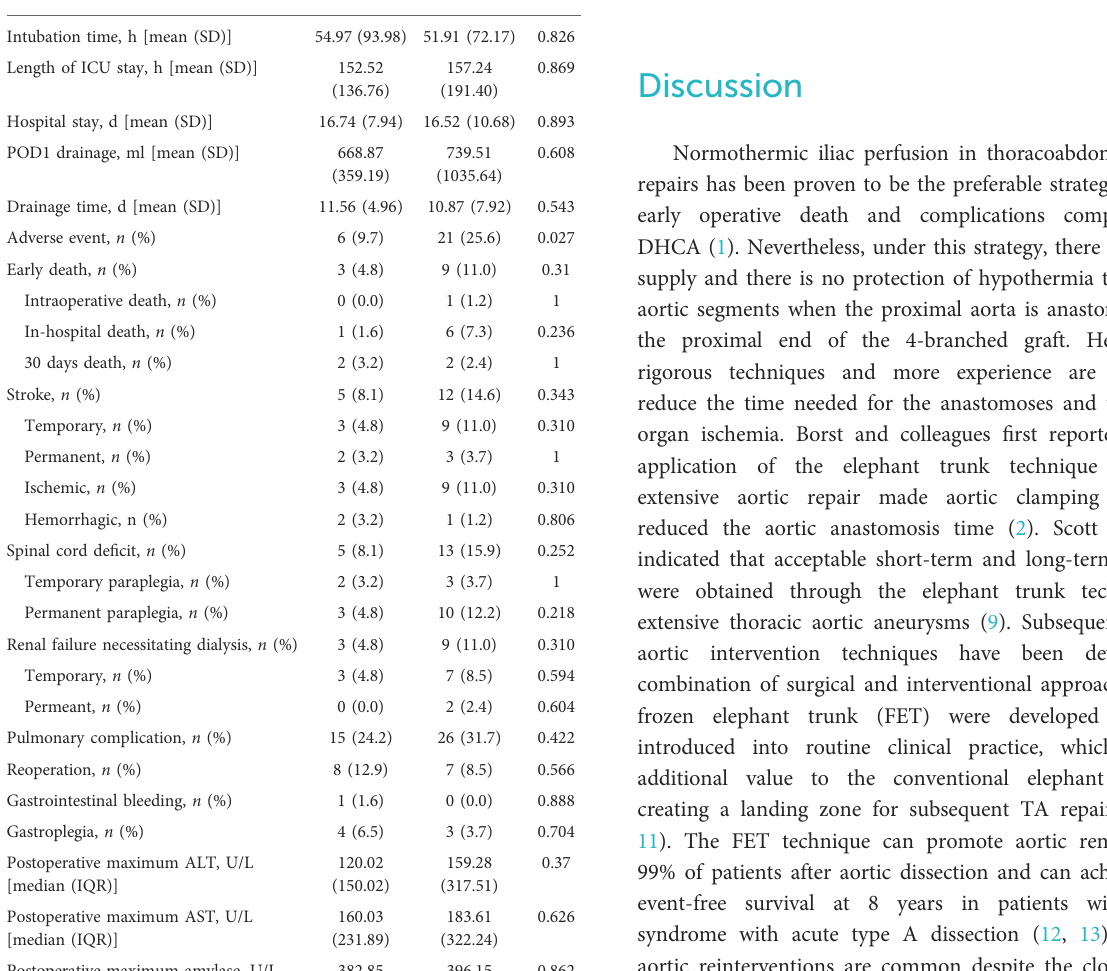
( Figure 2B ). In addition, K-M curve was cut off at 60 months due to the high standard error (>0.1 in the two groups).